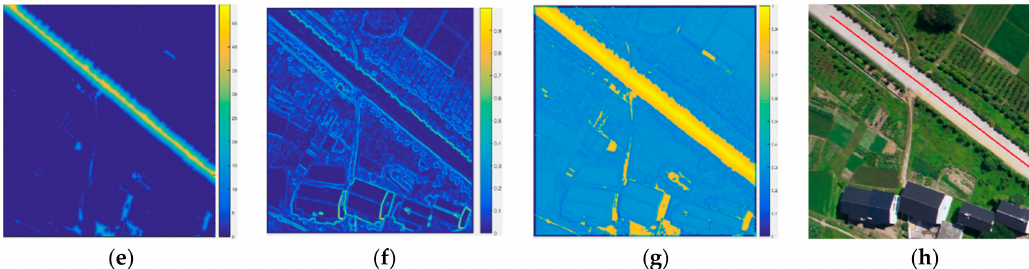
Figure 2. ( a ) Test image. Seed points are represented by red crosses; ( b ) Image preprocessed through guided filtering; ( c ) Mahalanobis distance map; ( d ) Thresholding result, in which 1 and 0 represent road and nonroad classes, respectively; ( e ) Distance transform result; ( f ) Edge-energy information; ( g ) Road probability map obtained through multifeature fusion; ( h ) Minimal path extracted from the road probability map through the fast marching